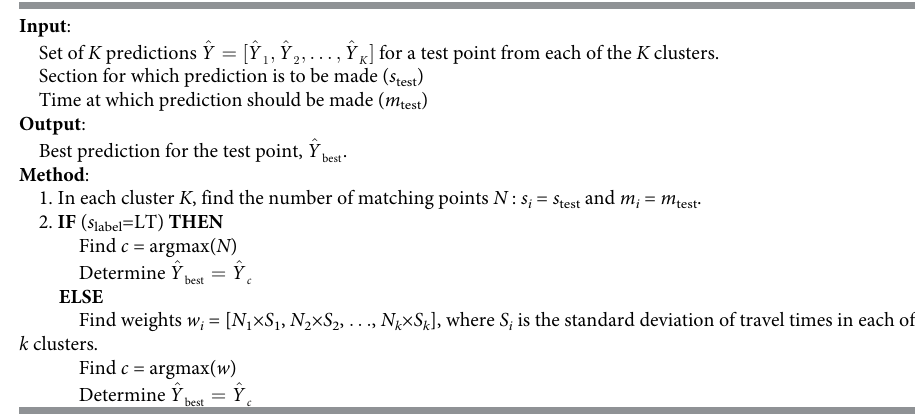
Table 4. Revised selection-based criterion.